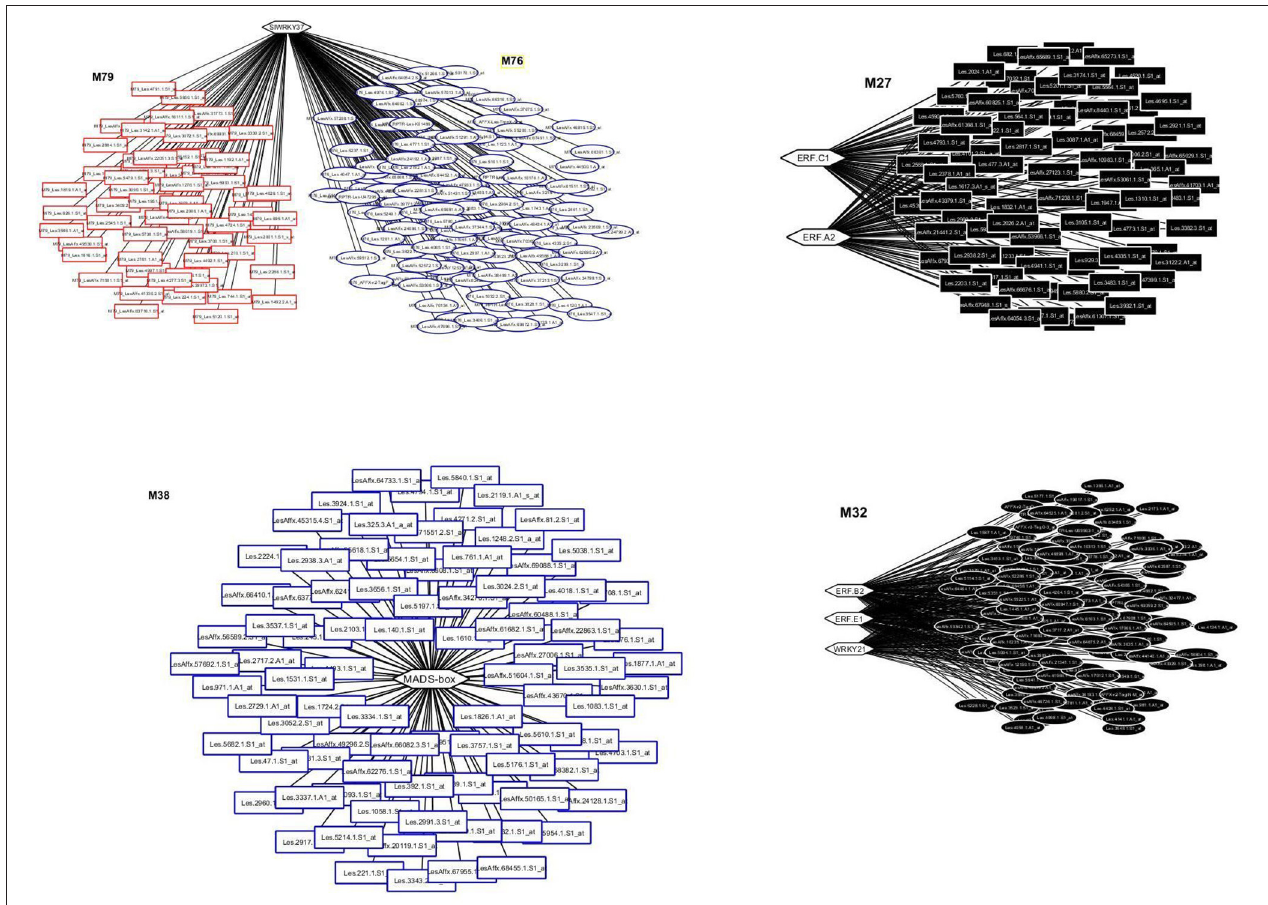
FIGURE 1 | Transcriptional regulatory networks in tomato fruit ripening using publicly available microarray data. The top left panel represents the WRKY37 network with modules, M76 and M79 comprising 119 and 59 transcripts, respectively. The top right panel represents the ERF.C1 and ERF. A2 network with one module, the M27 comprising 77 transcripts. The low left panel represents the MADS/TM29 network with one module, the M38 comprising 88 transcripts. The low right panel represents the ERF.B2, ERF.E1, and WRKY21 network with one module, the M32 comprising 123 transcripts. Modules are color-coded and numbered. Hexagons represent transcripts encoding transcription factors whereas rectangles and ellipses represent transcripts regulated by